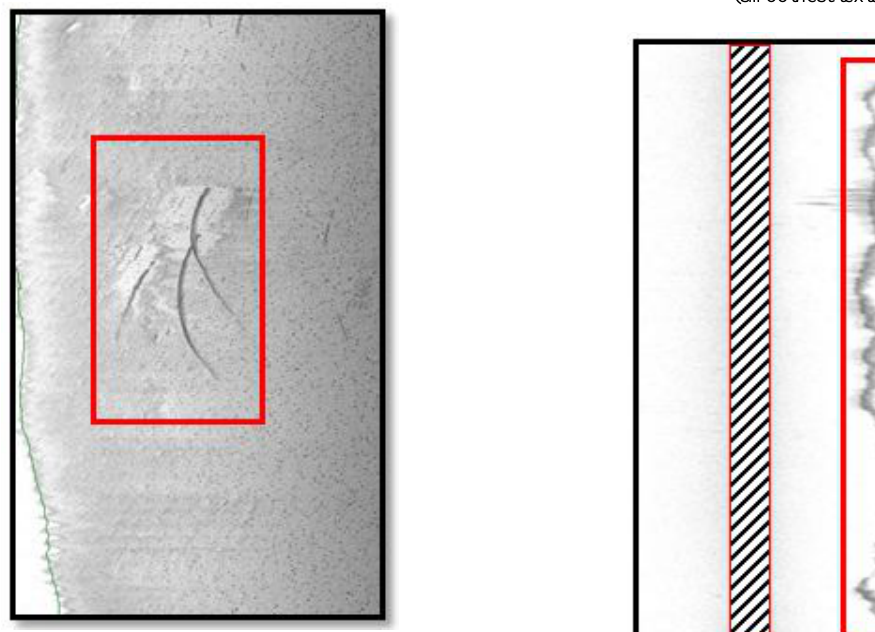
Figure 3. The shadow of the snag in backscatter image at the upstream area (roughest textures)